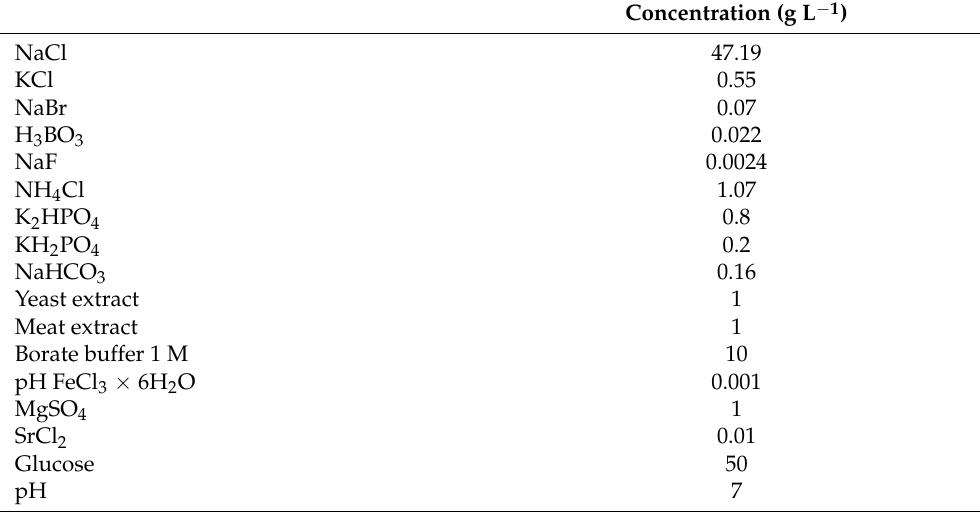
Table 1. SG17 element